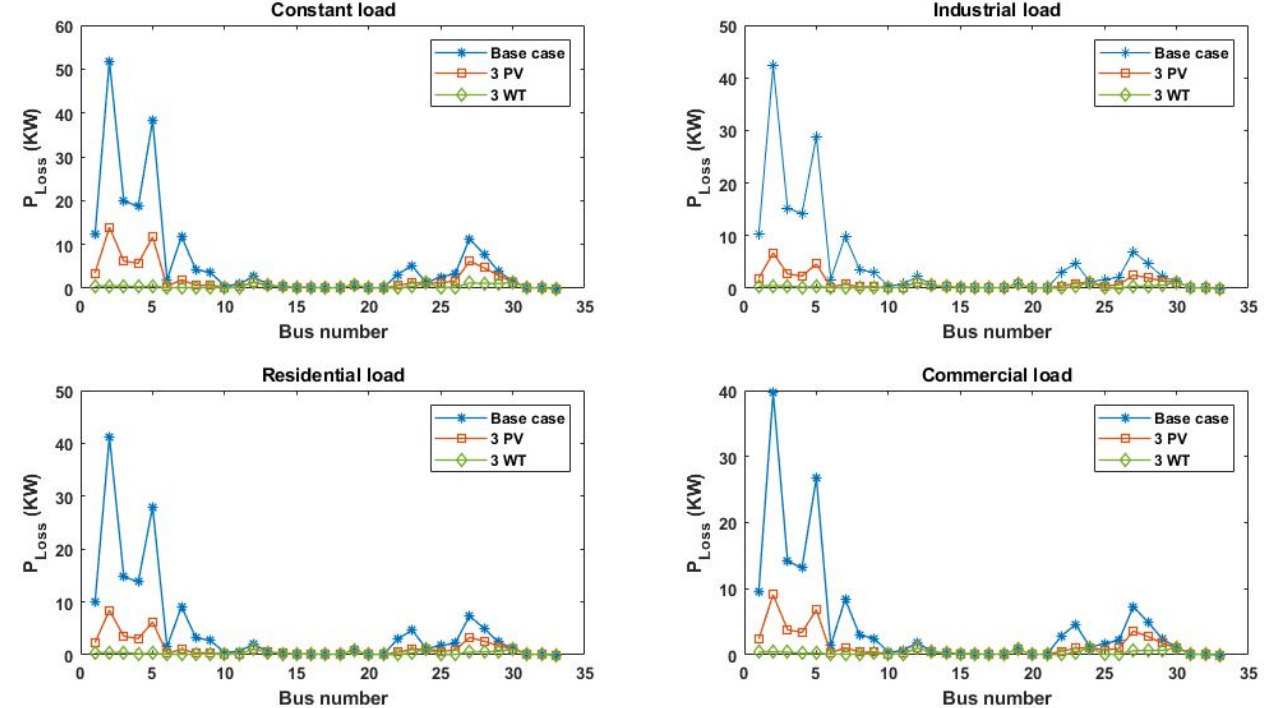
Figure 5. Active power loss for a 33-bus RDS for various types of loads, under scenario 1.